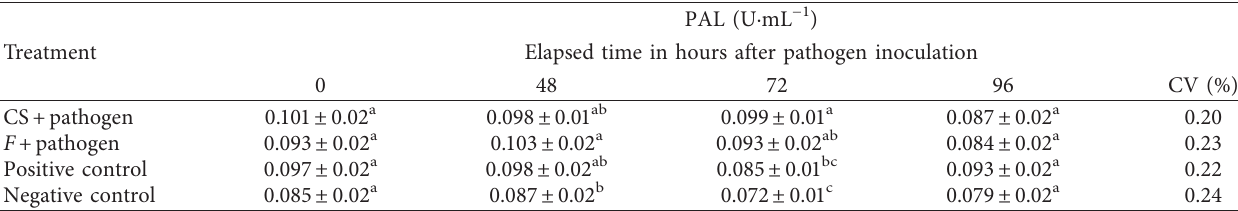
Table 4: Average phenylalanine ammonia lyase (PAL) activity in guarana leaves.